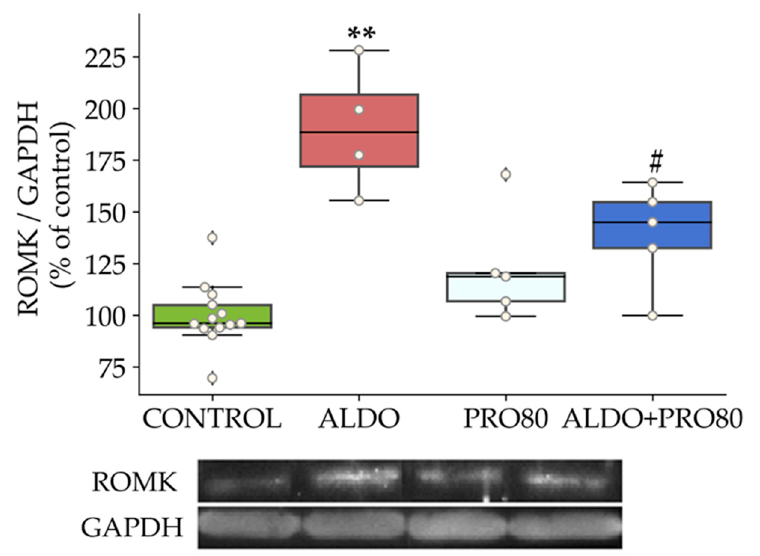
Figure 2. PRO80 effects on aldosterone-disbalanced potassium outflow. Relative protein expression levels of the renal outer medullary potassium channel (ROMK) by western blot. The boxplots show median, first and third quartile, and minimum and maximum values; the dots show individual values. ** p < 0.01 vs. control; # p < 0.05 vs. ALDO. control: Control group; ALDO: Aldosterone-salt group; PRO80: Proanthocyanidins-80% enriched extract group; PRO80+ALDO: Aldosterone plus proanthocyanidins-80% enriched extract group ( n = 8).